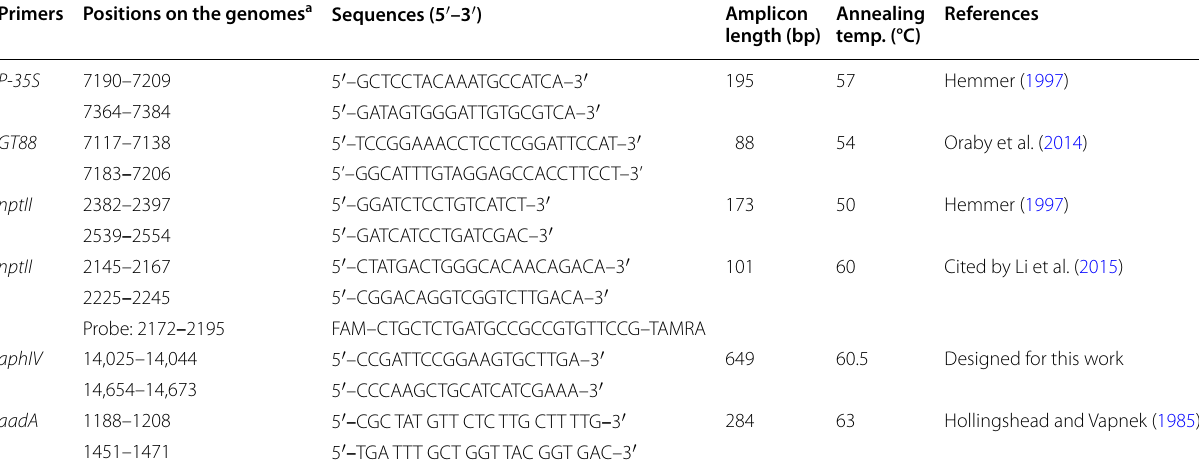
a Primers positions relevant to: Cauliflower mosaic virus genome (accession no. emb|V00141.1|), nptII gene (accession no. AF080390.1 ), aphIV gene (accession no. KY080693.1) and aadA gene (accession no. MH973510.1)